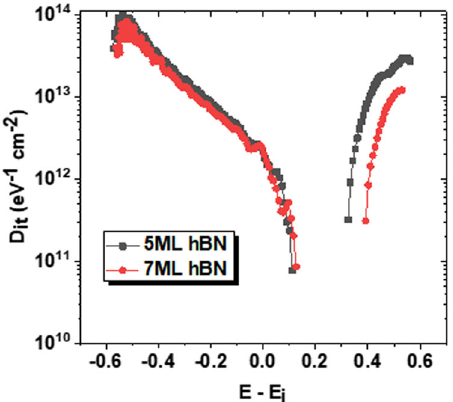
Fig. 5 Interface defect density at InP/hBN interface. The energy- dependent interface state density extracted for the hBN fi lms of different thickness from high-frequency (100 kHz) C – V measure- ments. Note that the apparent dip/minima between 0 and 0.4 eV is an expected artifact of the extraction method and should be ignored. D it at the intrinsic Fermi level E i is ~2 × 10 12 eV − 1 cm − 2 in both cases, and slightly higher at midgap (~37 meV < E i for InP at room